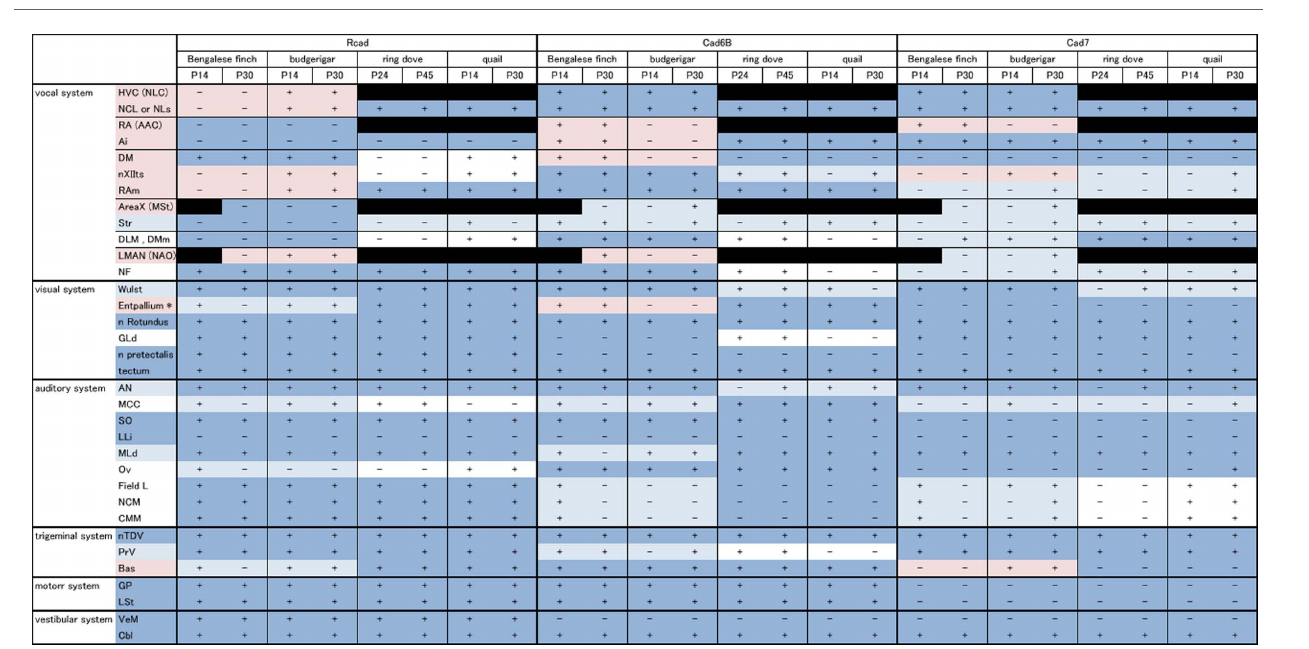
Table 1 | Summary of comparative gene expression among vocal learners (Bengalese finch and budgerigar) and non-learners (quail and ring dove).